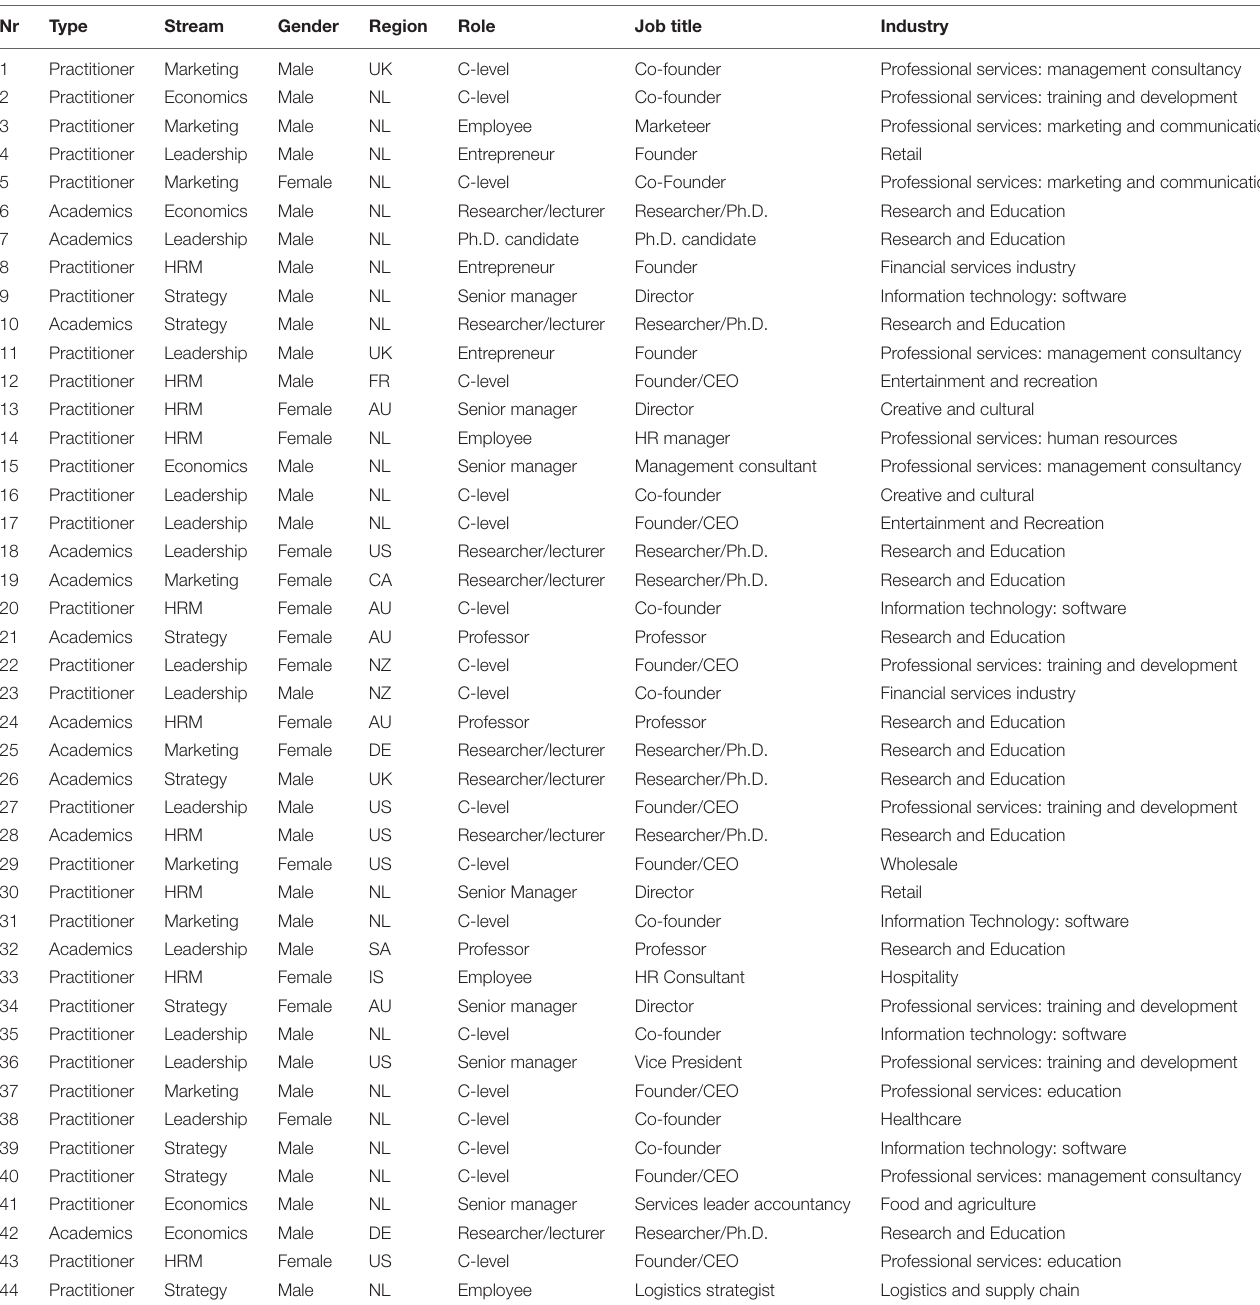
TABLE 2 | Interviewee